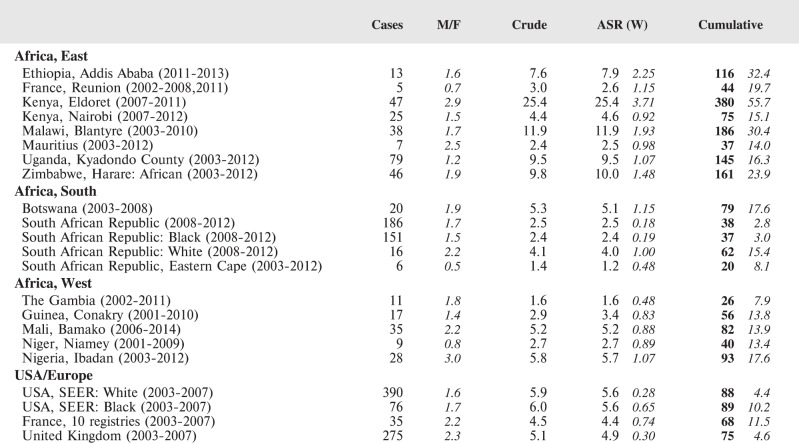
Crude, age-standardised (world) and cumulative (0–14) incidence rates (per million) and standard errors – NHL (except Burkitt).